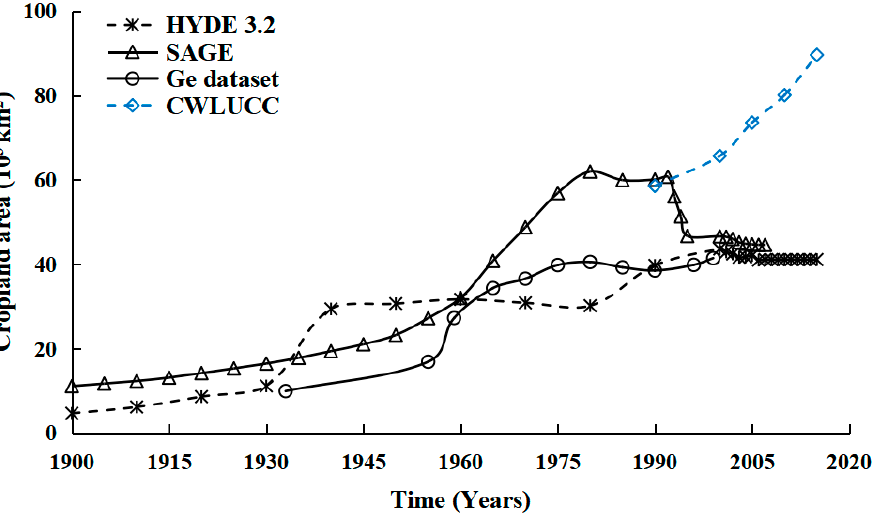
Figure 3. Trends in cropland area change for Xinjiang province over the past 100 years from HYDE 3.2, SAGE, the Ge dataset, and